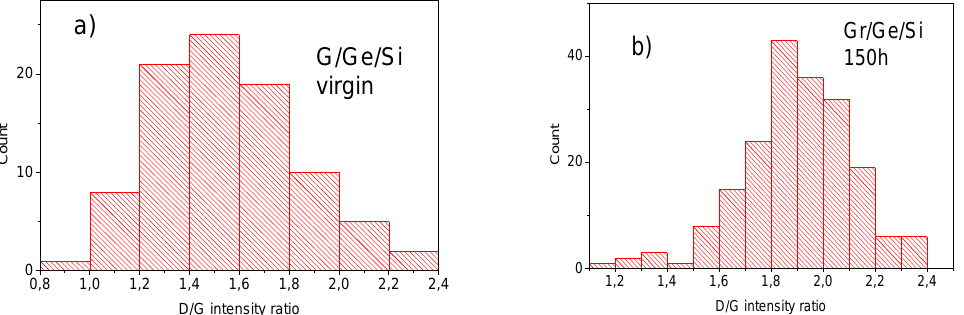
Figure 7. Histograms of the intensity ratios D/G for Gr/Ge(001)/Si(001) samples before ( a ) and after 150 h of water vapor treatment ( b ). The data come from the maps of the Raman spectra taken in 100 points ( a ) and 150 points ( b ) (“count” means the number of points for indicated range of the parameters